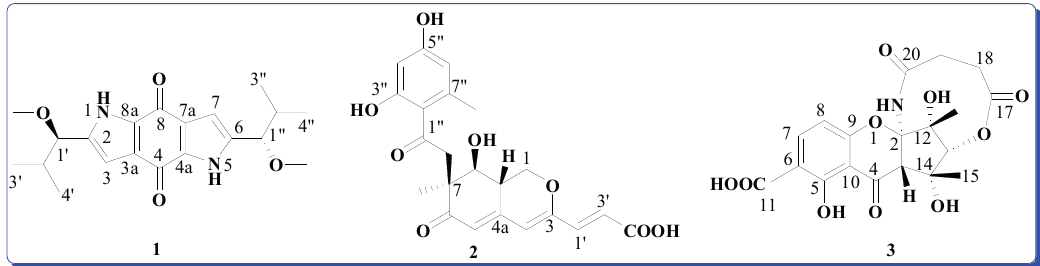
Figure 1. The structures of compounds 1 – 3